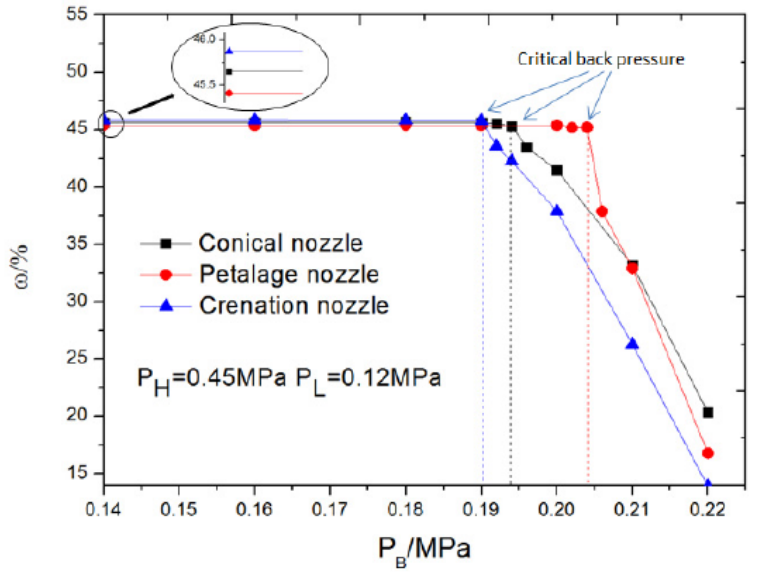
Figure 9. Entrainment ratio vs. back pressure for different nozzle geometries [59] Elhub et al. [60] studied the optimum position of nozzle exit for cooling cycle in R134a refrigeration systems, through computational method. An extended work is presented with a provision for a movable ejector at varying distance from 2 to 8 mm, to accommo- date varying operational requirements and conditions. At low distance, improper mixing between primary and secondary flow resulted in low entrainment, while at higher dis- tance, outlet pressure is found to be more dominant in causing back pressure, hence 3 mm is the optimum distance at which entrainment ratio of about 0.7 was achieved. Seckin [61] used an empirical method to study the effect of constant pressure two- phase ejector primary nozzle throat diameter, on the ejector expansion refrigeration cycle using R134a as the refrigerant. At condenser temperatures of 50, 60 and 70 °C and evapo- rator temperatures of 0 °C, nozzle throat diameter, condenser temperature and entrain- ment ratio are affected. With increasing temperature of condenser, larger diameter noz- zles are required. Xu et al. [62] performed experimental investigation on supersonic (converging-di- verging with throat diameter of 1.3 mm and exist diameter of 1.36 mm) and subsonic (con- verging with throat diameter of 1.3 mm) nozzle with variable geometry ejector to utilize unstable solar heat as driving energy for stable refrigeration systems. The diameter and length of mixing sections are 2.08 and 10.0 mm, respectively. Driving and suction flow are induced through generator and evaporator, respectively, using R134a as working fluid. Variable geometry ejectors were found to have achieved better performance in varying operating conditions and supersonic nozzles were found to demonstrate better perfor- mance compared to subsonic nozzles. Figure 10 shows the performance of ejectors for